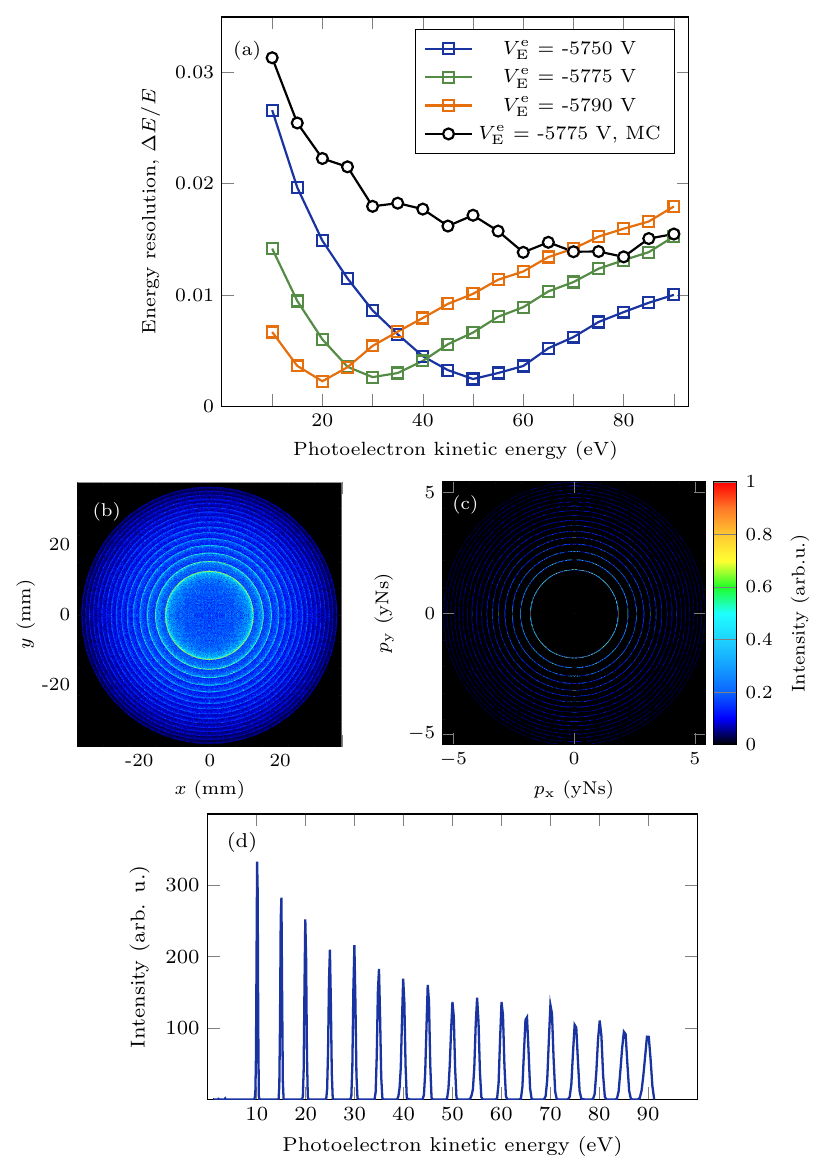
Figure 3. Simulation results for high resolution electron VMI mode. ( a ) shows the resulting energy resolution for three different extractor voltages ( V e ) using the 27-particle model (blue, green and orange E lines) and the Monte Carlo model for the optimum setting (black line); ( b , c ) show the simulated detector image and the 3D momentum distribution after inversion, for the optimum voltages; ( d ) shows the photoelectron energy spectrum calculated from the 3D momentum